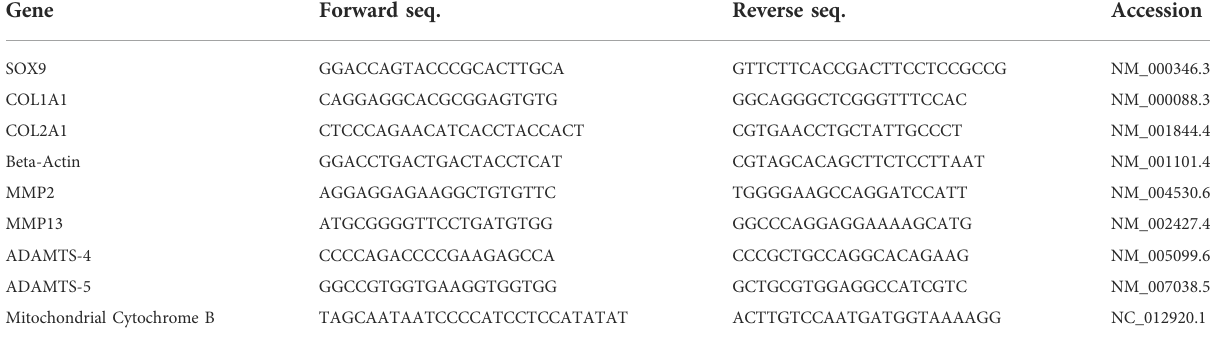
TABLE 1 List of forward and reverse primers, in 5 ’ to 3 ’ orientation, used for Real-Time Quantitative PCR. NCBI accession identi fi cation numbers of target sequences are included for each primer pair. Gene Forward